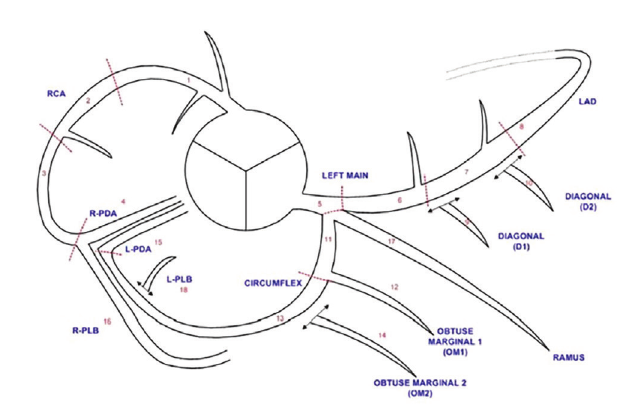
Figure 3. Coronary segmentation diagram by Society of Cardiovascular Computed Tomography (SCCT)